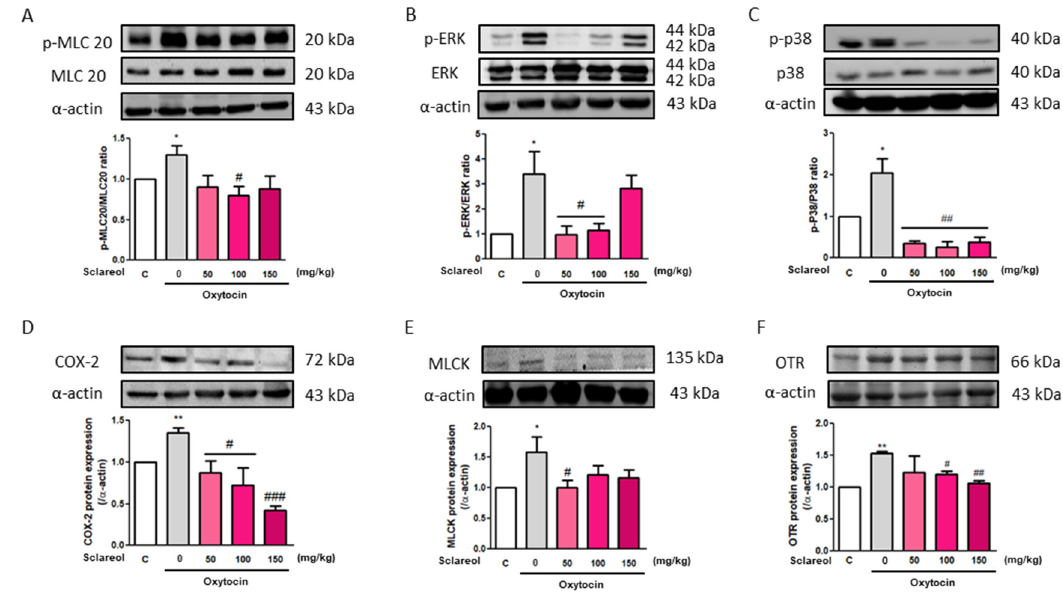
Figure 7. Effect of sclareol on uterine contraction-related protein expression in oxytocin-induced writhing test model. The ( A ) p-MLC20 / MLC20, ( B ) p-ERK / ERK, ( C ) p-p38 / p38, ( D ) COX-2, ( E ) MLCK, and ( F ) oxytocin receptor (OTR) levels were detected by Western blot. C, Control; 0, model control group; 50, sclareol 50 mg / kg; 100, sclareol 100 mg / kg; 150, sclareol 150 mg / kg; n = 4–6; * p < 0.05, ** p < 0.01 compared to C; # p < 0.05, ## p < 0.01, ### p < 0.001 compared to the sclareol 0 mg / kg group. Each column represents the mean ± SEM; n = 3–5.